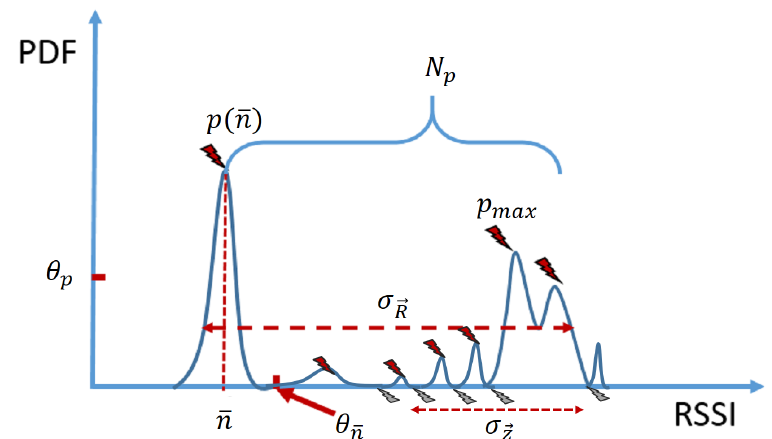
Figure 8. An illustration of the features extracted from the distribution of RSSI.